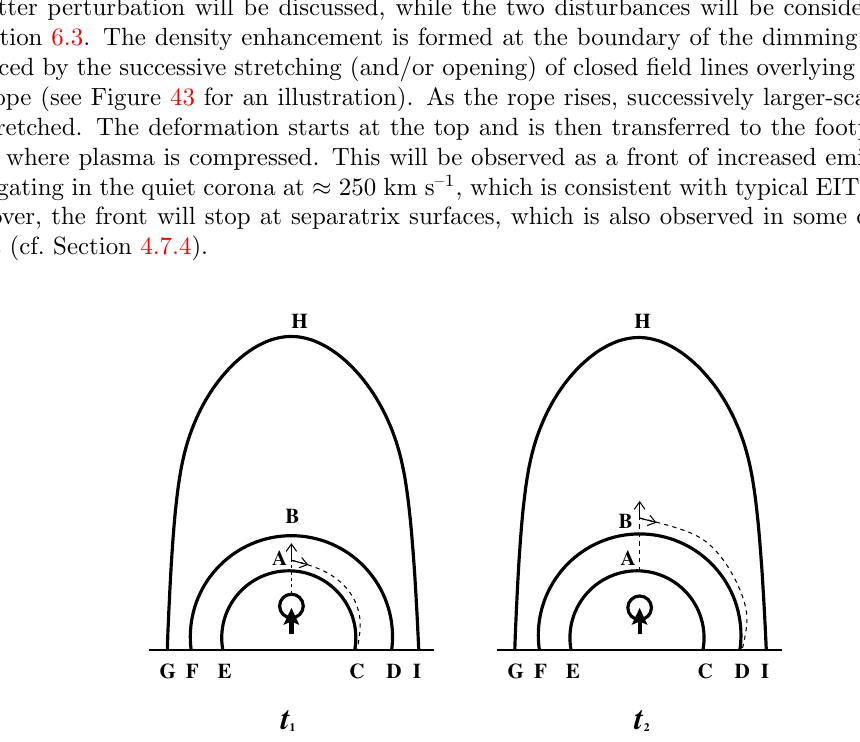
Figure 43: The principle of the field line stretching model illustrated as a cartoon. The erupting flux rope deforms progressively higher overlying field lines ( A,B ), and this perturbation is transferred from the top to the footpoints ( C, D ) of the loops. This creates a moving density enhancement. Image reproduced with permission from Chen et al. (2005b), copyright by